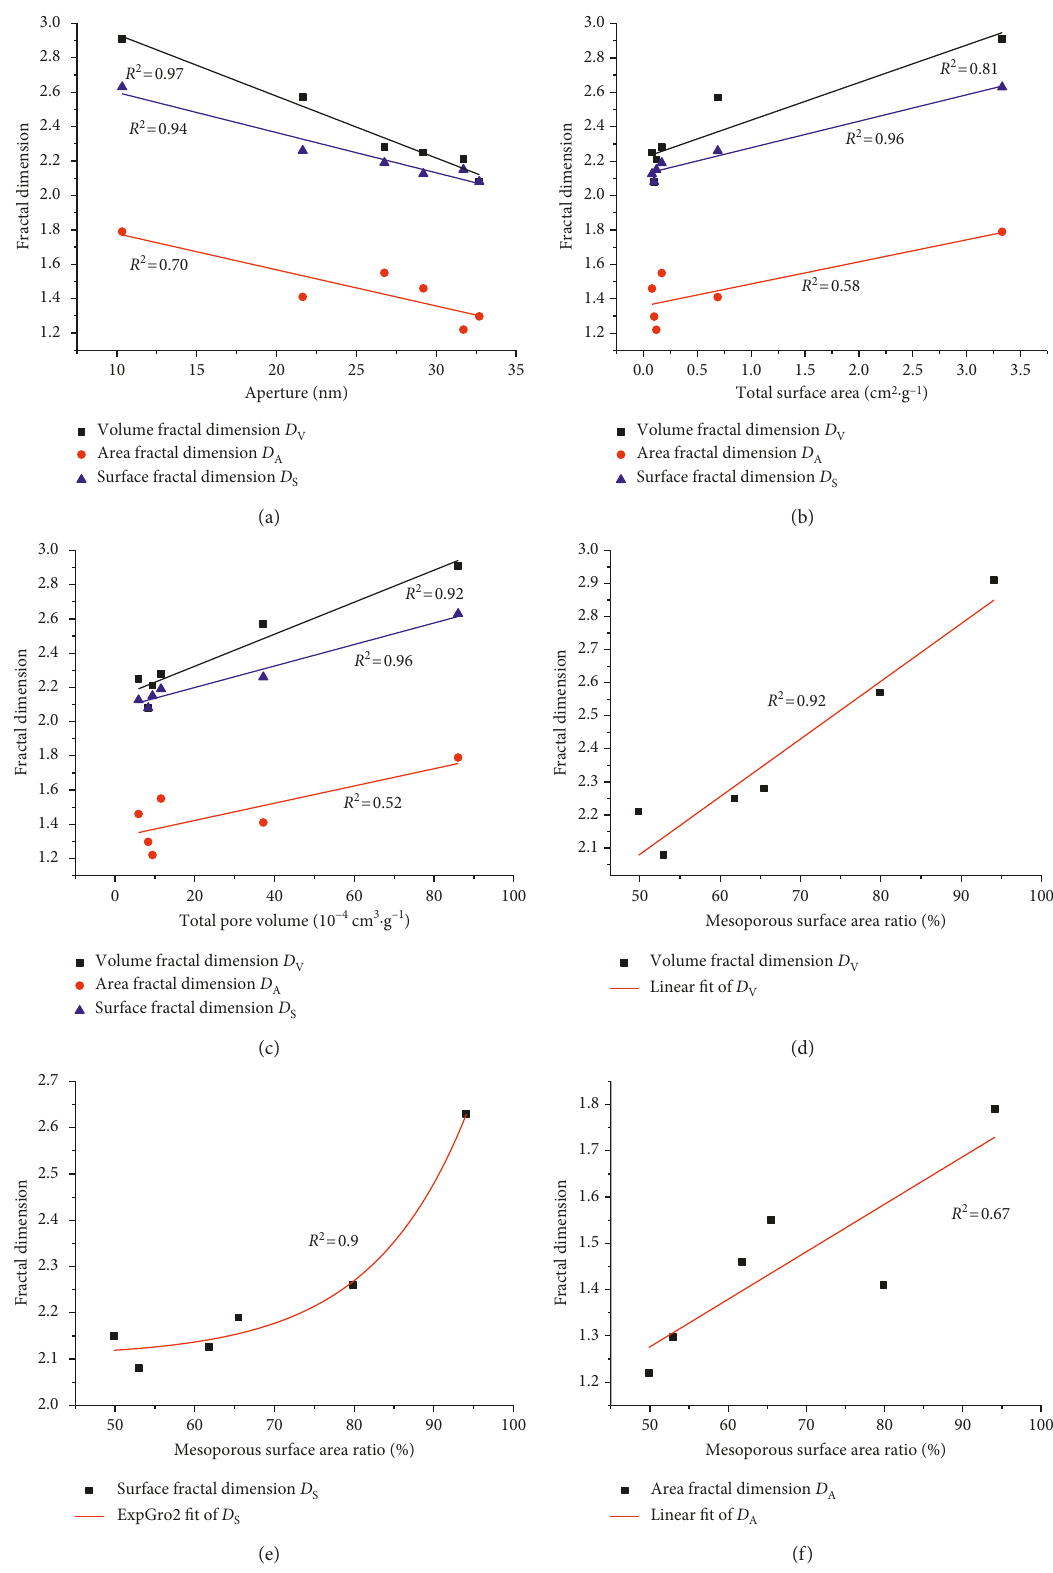
Figure 11: Relationship between the pore fractal dimension and the pore structure parameters for the B-1 to B-6 coal